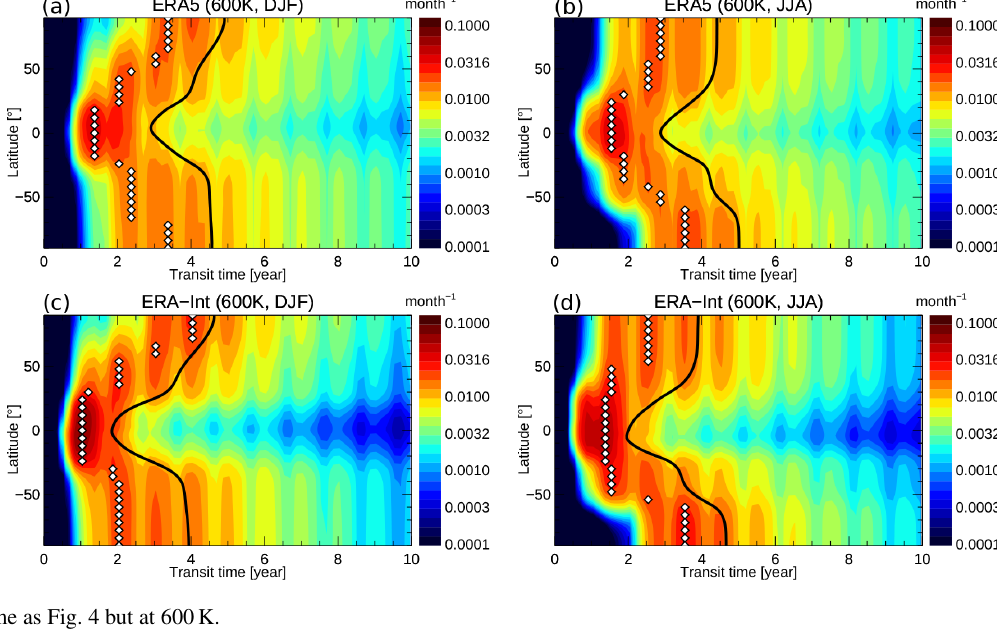
Figure 5. Same as Fig. 4 but at 600K.